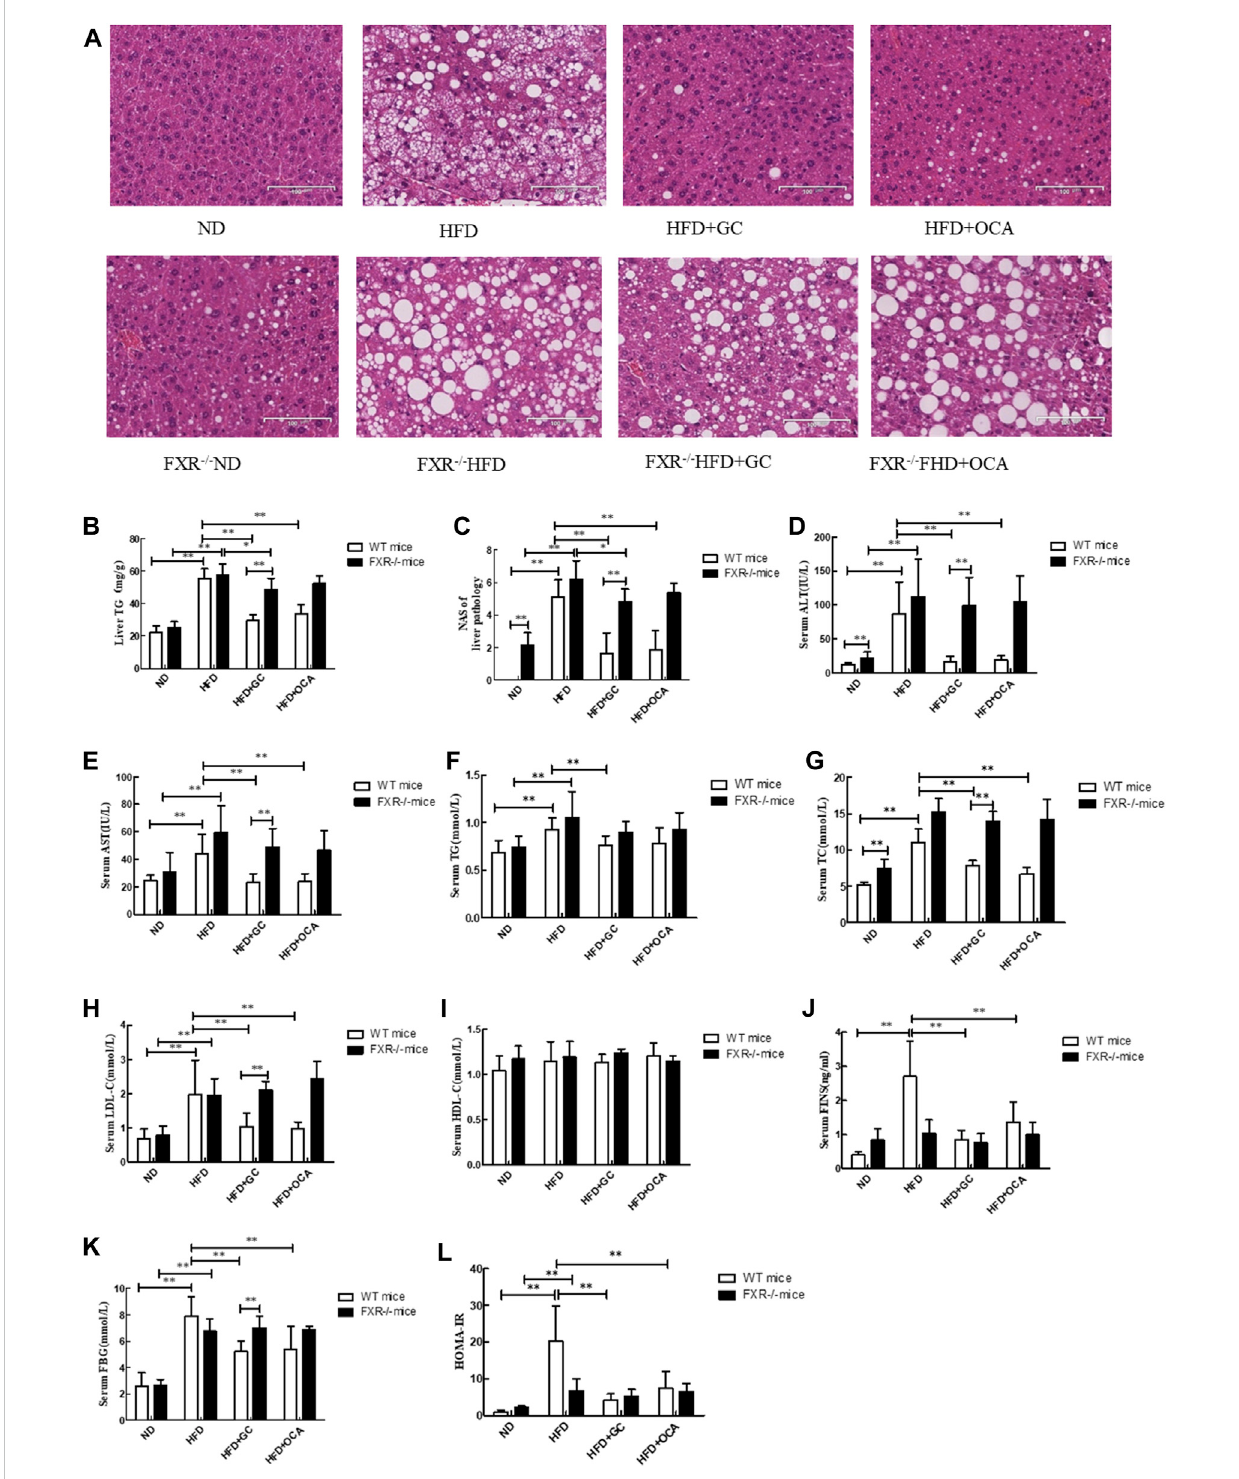
FIGURE 4 Changes in liver morphology, NAS and biochemical indexes with intervention of GC or OCA in wild-type and FXR − / − mouse NAFLD models. (A) H&E staining,×200. (B) Liver TGlevel. (C) Liver NAS. (D) SerumALT level. (E) Serum ASTlevel. (F) SerumTG level. (G) SerumTC level. (H) Serum LDL-C level. (I) Serum HDL-C level. (J) Serum FINS level. (K) Serum FBG level. (L) HOMA-IR. Abbreviations: NAFLD, non-alcoholic fatty liver disease; ND, normal diet; HFD,high-fatdiet;GC,geniposideandchlorogenicacidcombinationtreatment;OCA, obeticholicacid;TG,triglyceride;NAS,NAFLDactivityscore; ALT, alanine aminotransferase; AST, serum aspartate aminotransferase; TG, triglyceride; TC, total cholesterol; LDL-C, low-density lipoprotein cholesterol;HDL-C,high-densitylipoprotein cholesterol; FINS,fastinginsulin;FBG,fastingbloodglucose;HOMA-IR,HomeostaticModel Assessment of Insulin Resistance; WT, wild type; FXR − / − , FXR knockout. * p < 0.05 and ** p < 0.01 ( n = 9 per